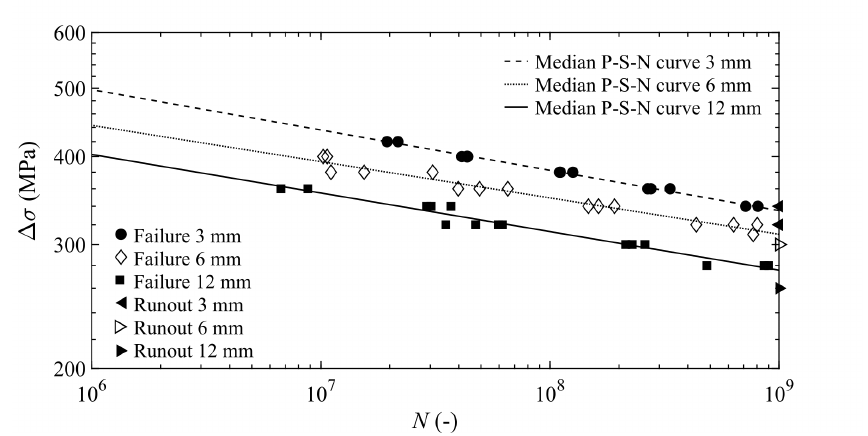
Figure 16. Specimen-size dependent median P-S-N curves in VHCF regime.